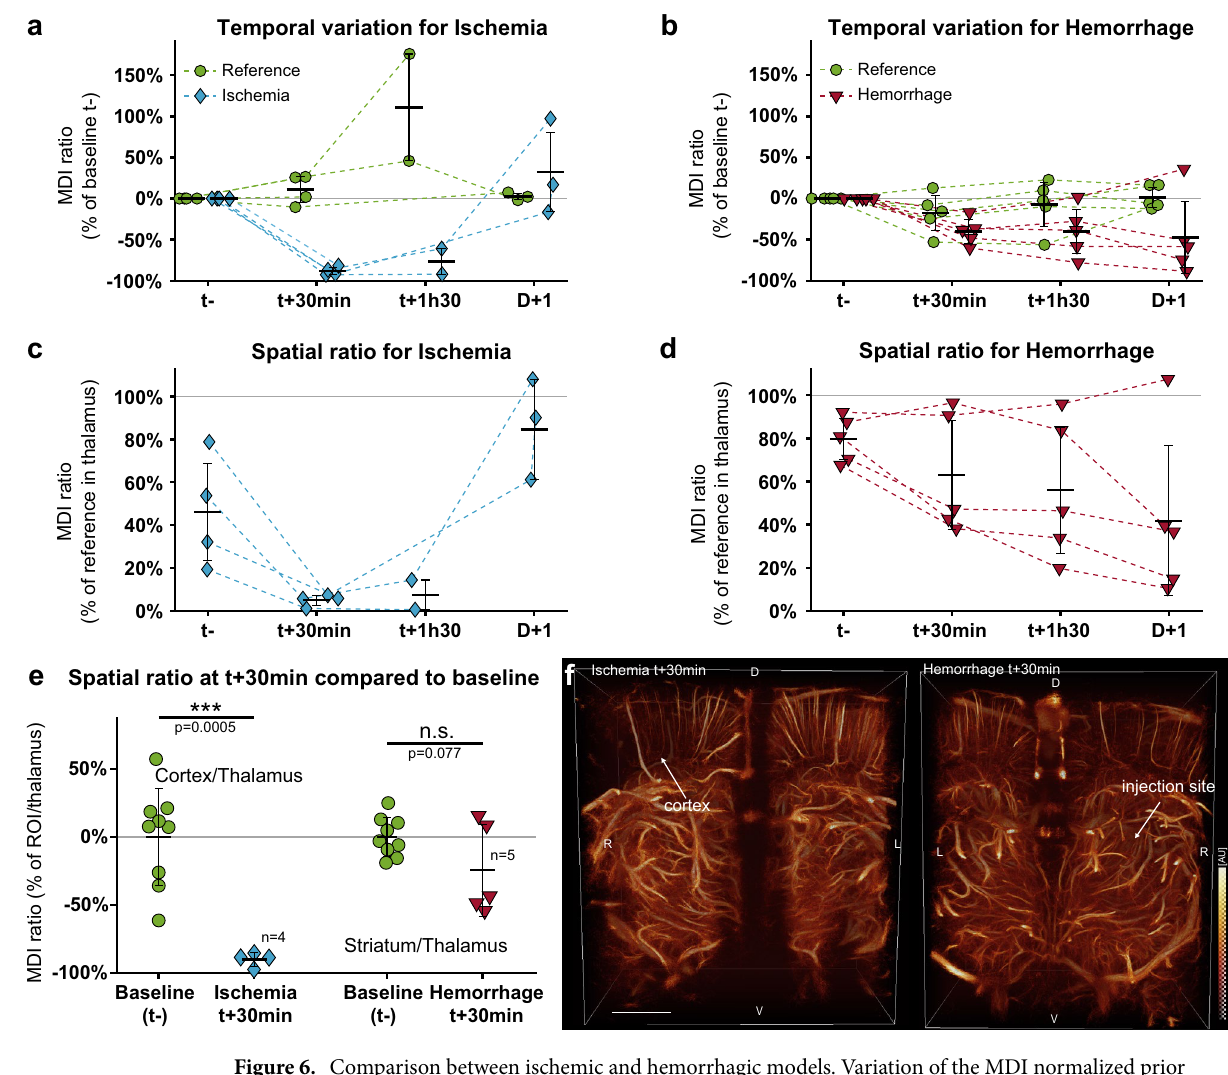
Figure 6. Comparison between ischemic and hemorrhagic models. Variation of the MDI normalized prior onset (t−) for each ROI in the ischemic ( a ) and hemorrhagic ( b ) stroke and reference ROIs. Ratios between the ischemic ( c ) and hemorrhagic ( d ) strokes ROI and the reference region. ( e ) Normalized MDI ratio of the lesion site and the reference region, compared to the baseline (t-). All animals were pooled for baseline ratio in cortex and striatum (n = 9). Student t-test with equal variance ( f ) Volume renderings of ischemic (left) and hemorrhagic (right) strokes 30 min after onset. Scale bar 2 mm. Figures were created with ( a–e ) MatLab 2019a (https:// www. mathw orks. com/ produ cts/ matlab), ( f ) Amira 2019.4 (https:// www. therm ofish er. com/ amira-